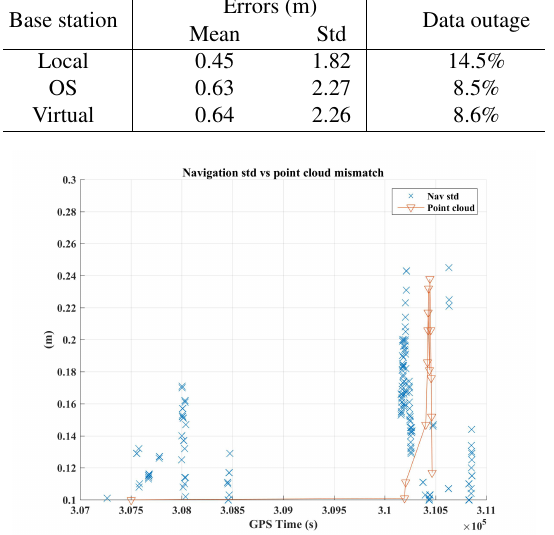
Table 4: Change detection level from point clouds (m)